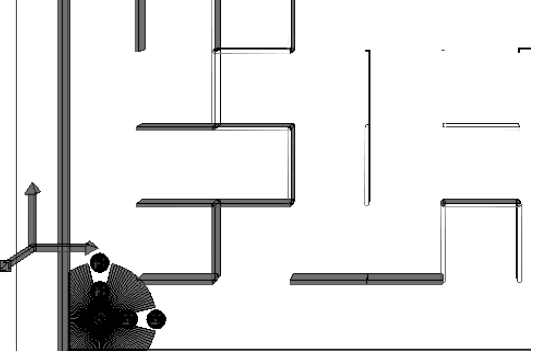
Figure 15. Robot placement setup at starting time. Robots are represented by black dots. The sensing scope of the robot placed right in the corner is represented by a grey area where it is possible to see the laser aces and the obstruction caused by some teammates. Robots are placed from the corner along the x and y axes. As the fleet size increase, new robots are placed next following the row of robots on each axis,